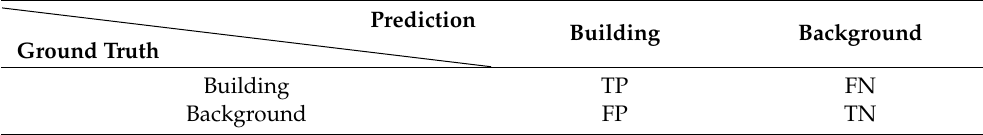
Table 4. Confusion